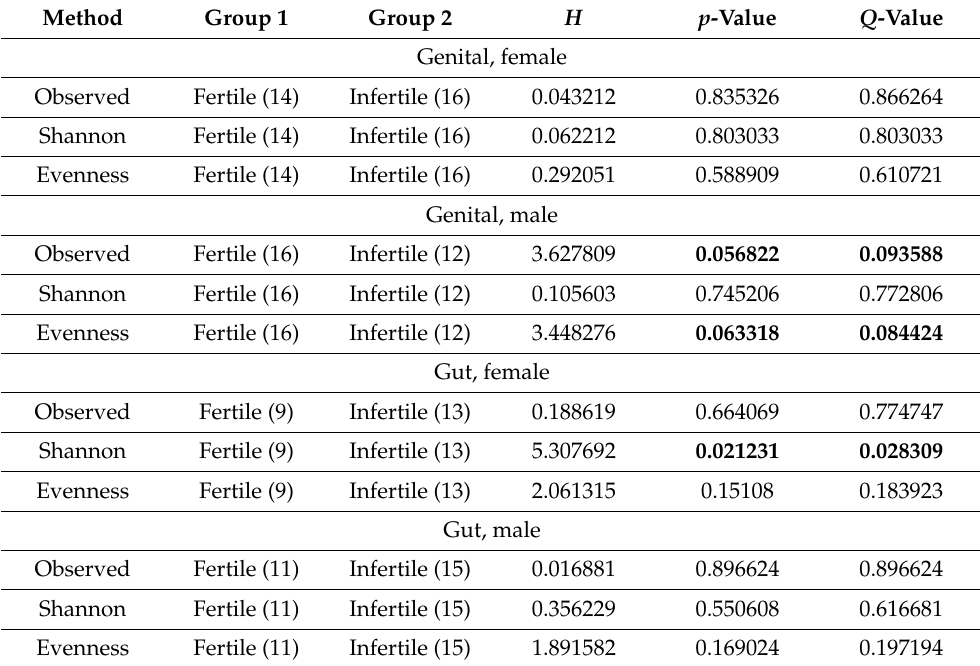
Table 7. Differences in the alpha-diversity of MetaCyc pathways between samples. (<0.1 are in bold).